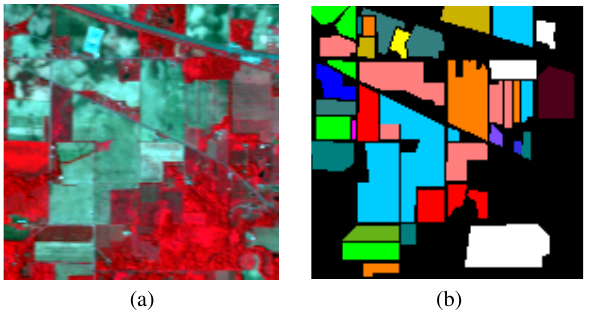
Figure 2: Indian Pines 1992 AVIRIS data.(a) False color compo- sition and (b) Ground truth (for color legend, see Tab. 1). Unla- beled samples are in black. Table 1: Classes and Samples ( n c Indian Pines 1992 dataset (cf. Fig. 2).